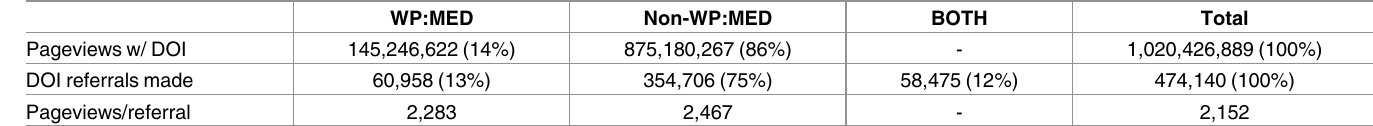
Table 6. Pageviews of pages with at least one DOI citation and the referralsfrom DOI citations during August 2016.